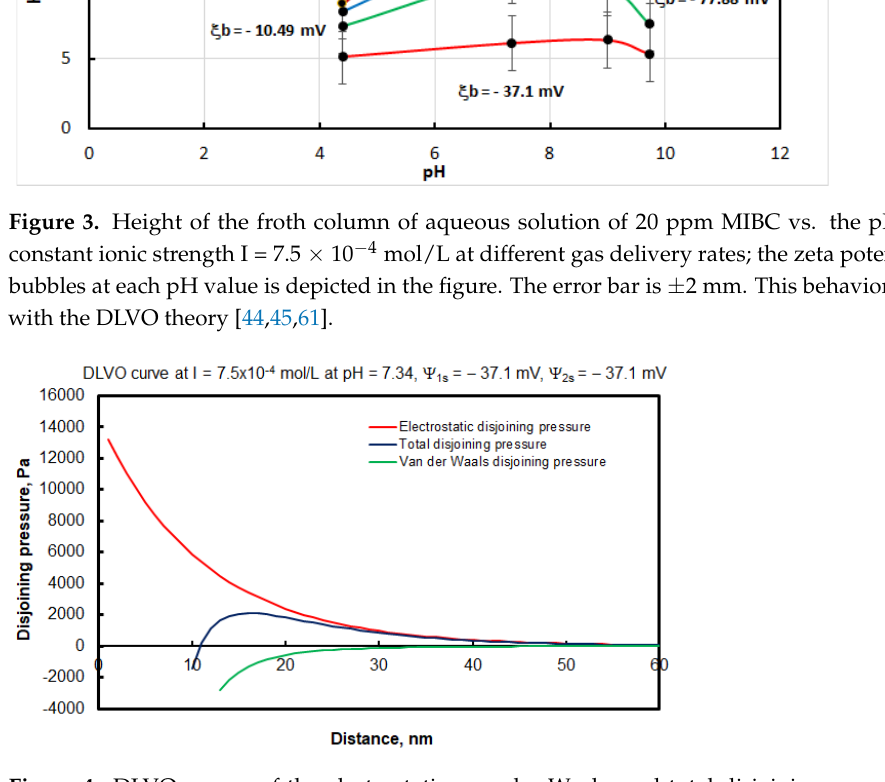
Figure 3. Height of the froth column of aqueous solution of 20 ppm MIBC vs. the pH value at con ‐ stant ionic strength I = 7.5 × 10 − 4 mol/L at different gas delivery rates; the zeta potential of the bubbles at each pH value is depicted in the figure. The error bar is ±2 mm. This behavior correlates with the